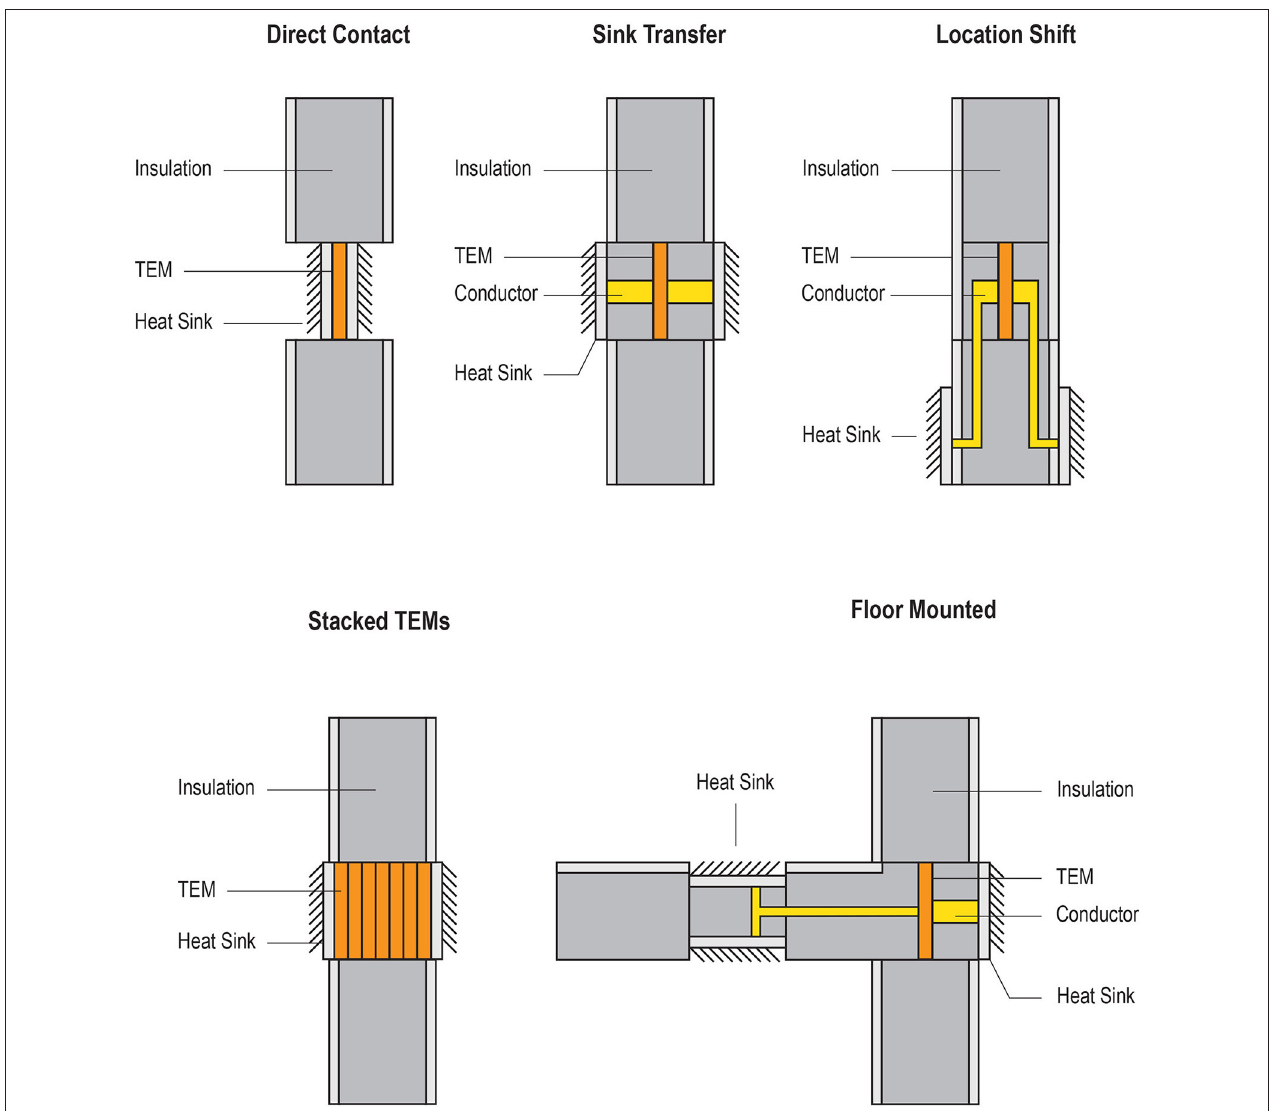
FIGURE 3 | Schematic representation of possible configuration and placement of TEMs in